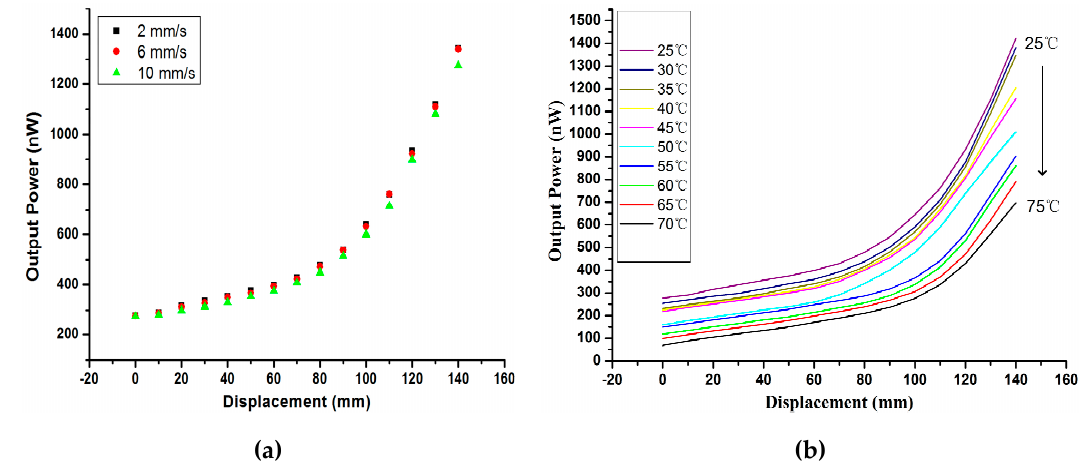
Figure 6. Output power of receiving fiber changes with displacement at different speeds ( a ); Output power of receiving fiber changes with displacement at different temperatures ( b ).